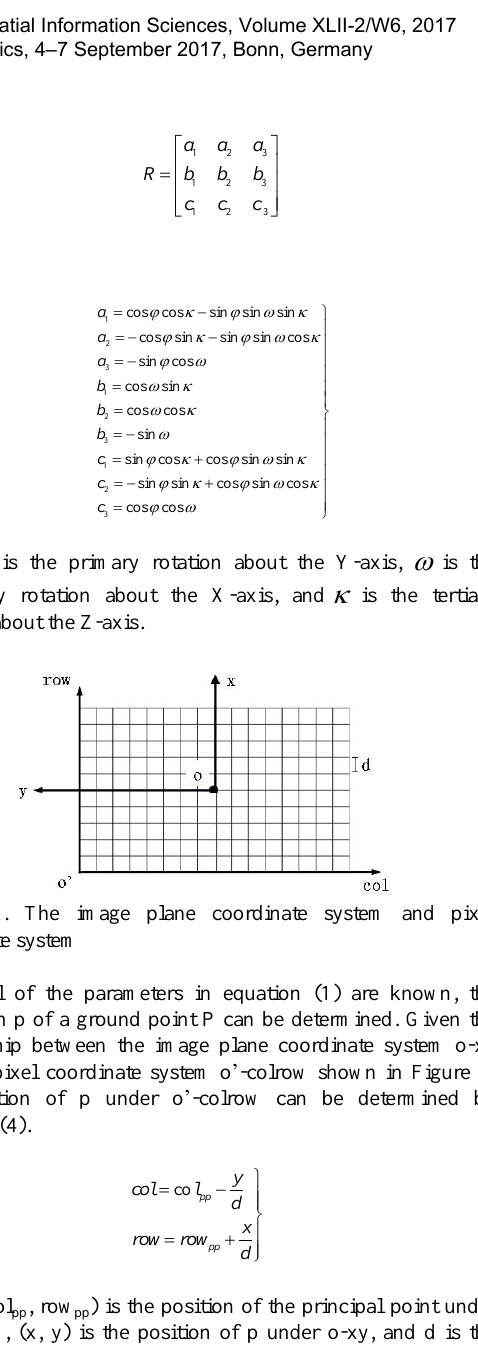
where (col pp , row pp ) is the position of the principal point under o’-colrow, (x, y) is the position of p under o-xy, and d is the pixel size.